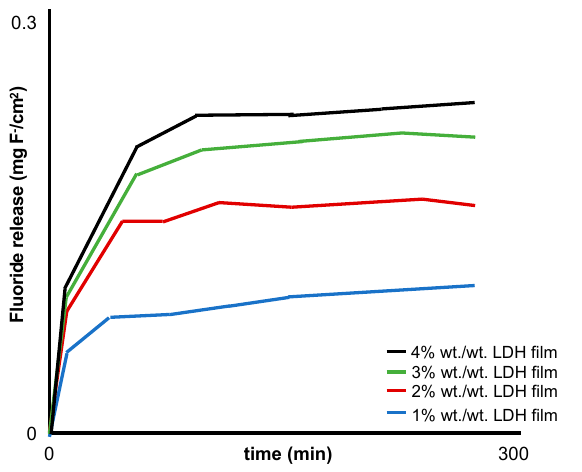
Figure 4. Modified schematic from Perioli et al. [30] representing the in vitro fluoride release profiles from a buccal muco-adhesive strip containing 1–4% w / w MgAl LDH.